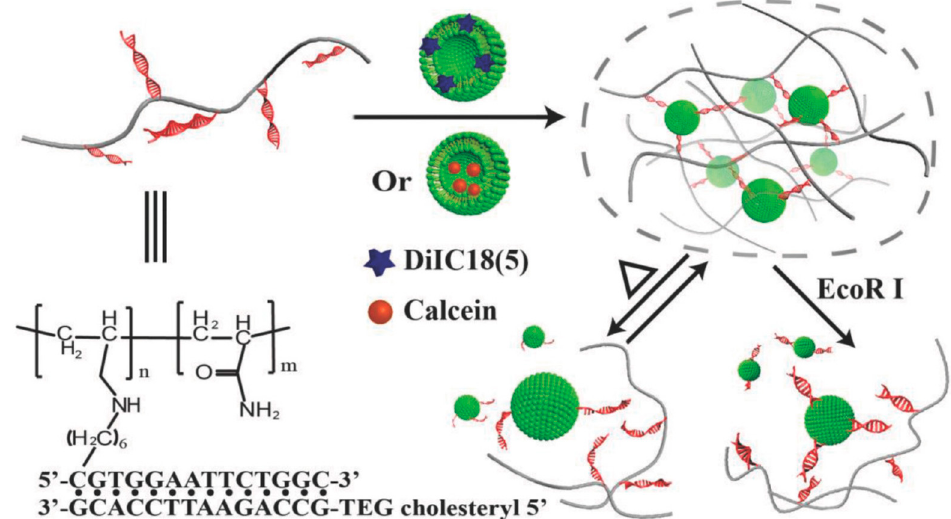
Figure 4. Schematic representation of the liposome–DNA hydrogel and its stimuli-responsive release behavior. Reproduced with permission from [85], copyright 2018, WILEY-VCH Verlag GmbH & Co.